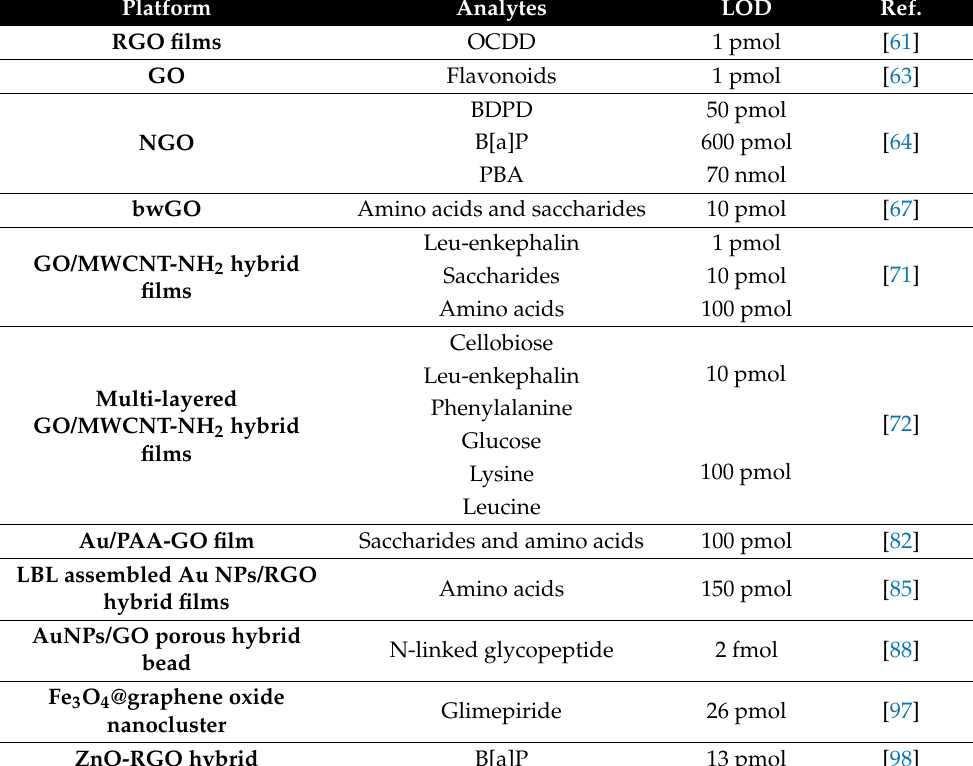
Table 1. A summary of various analytes and their LOD values for different types of GO derivatives and their nanohybrid structures for LDI-TOF-MS analysis of small molecules. Platform